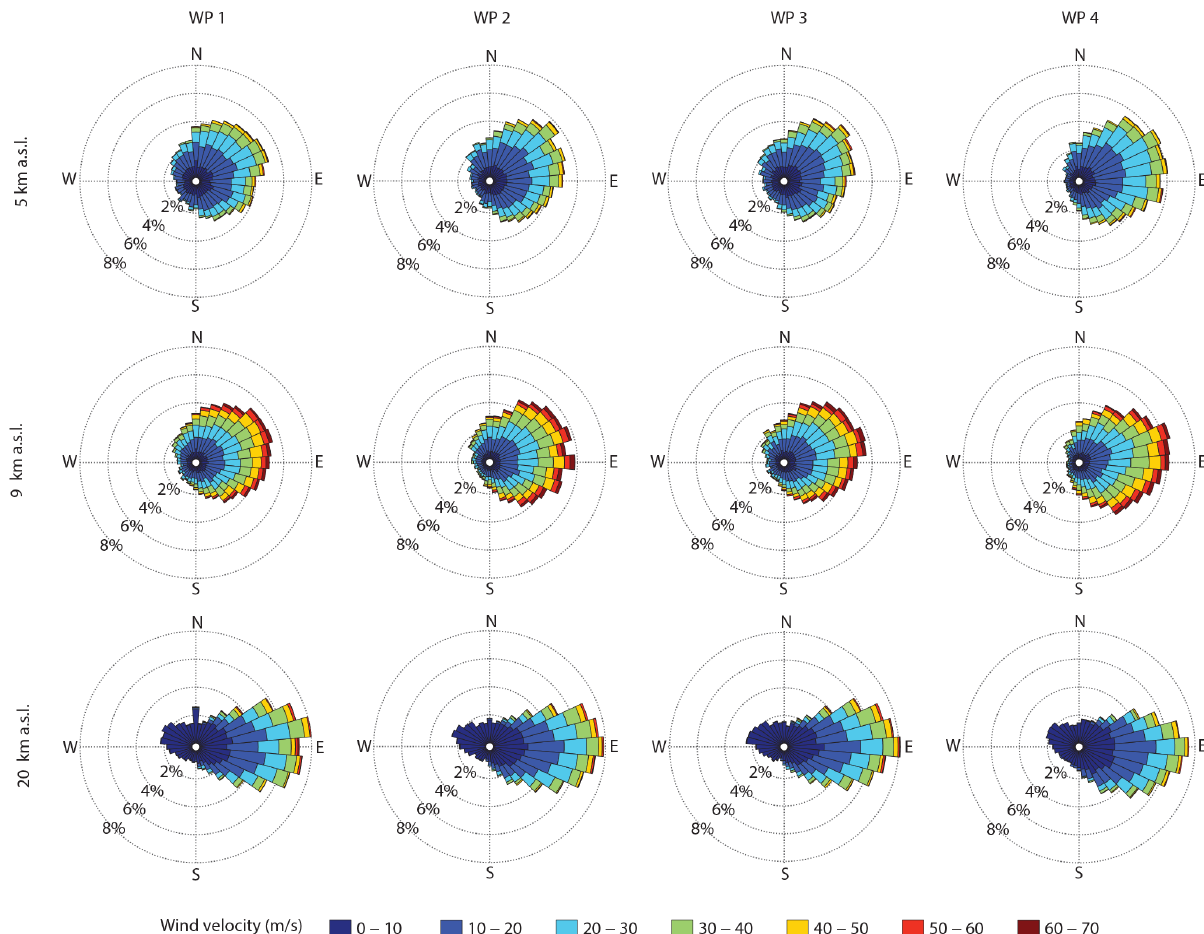
Figure 3. Wind analysis at three atmospheric levels along a N–S section from Reykjavík to the UK (Fig. 1) from the ERA-Interim Reanalysis database. These wind roses show the probability that the wind will blow in given directions and speed